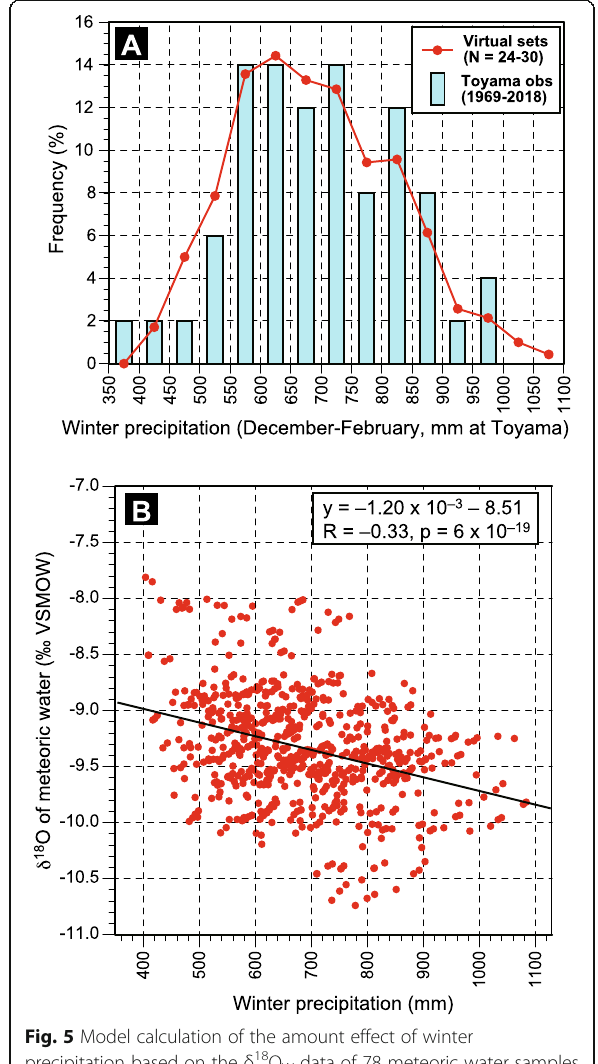
Fig. 5 Model calculation of the amount effect of winter precipitation based on the δ 18 O W data of 78 meteoric water samples collected during winter months (December to February) at Toyama (Sone et al. 2013). a Comparison of the frequency of winter precipitation based on 50 years of data from the Toyama weather observatory (1969 to 2018; blue bar) and 700 virtual model calculation sets (red plots). Resampling 24 – 30 rain/snow events best reproduced the observed frequency (mean and standard deviation) of cumulative winter precipitation. b Cross plot of winter precipitation and δ 18 O W in meteoric water. A weak but clear correlation is evident between these two variances